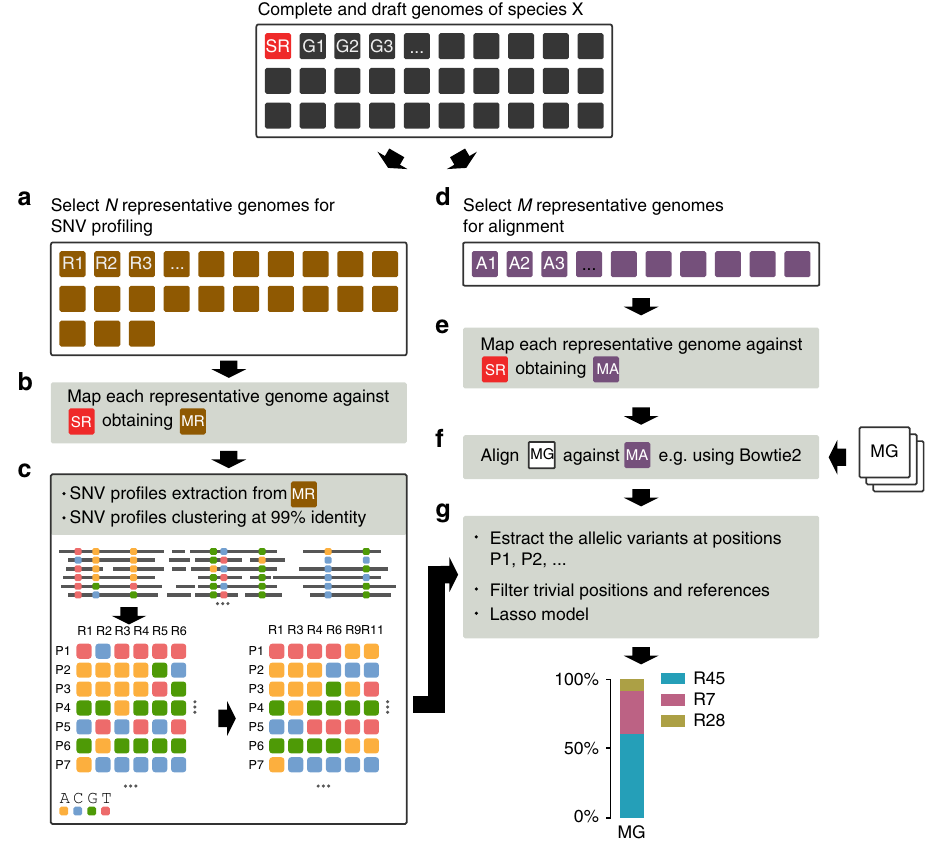
Fig. 1 StrainEst overview. a Given the complete and the draft genomes of the species of interest (G1, G2, … ) and the species representative (SR), the pairwise Mash distances are computed. Genomes with Mash distances > 0.1 from the SR are discarded and the remaining ones are clustered to remove redundant sequences. For each cluster, the genome with the lowest average distance from the other members is chosen as a representative (R1, R2, … ). b The representative sequences are mapped using nucmer against SR and ambiguous mappings are removed. c For each representative, the positions of the variant sites (P1, P2, … ) are identi fi ed and the SNV pro fi les are extracted. The pro fi les are clustered at 99% identity to guarantee their representativeness. d To create a reference set for metagenomic reads alignments that takes into account the variability of the species, representative genomes are selected for the metagenome alignment step (A1, A2, … ) and ( e ) mapped against SR. f For each metagenome (MG), the reads are aligned to the chosen genomes using Bowtie 2. g The frequencies of the allelic variants at the variant positions de fi ned in step ( c ) are extracted from the BAM fi le; sites with low coverage are fi ltered according to user-de fi ned fi ltering parameters; the relative abundance pro fi le is fi nally inferred by Lasso